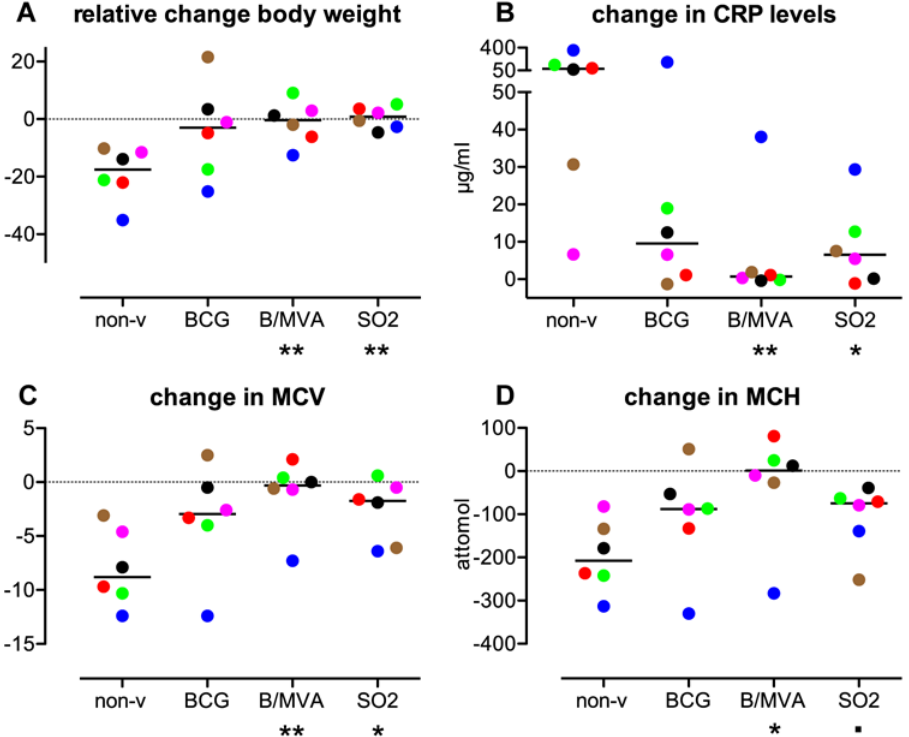
Figure 5. Evaluation of clinical measures along the infection phase. The BCG/MVA.85A regime and SO2 vaccination in comparison to non- vaccinated controls show significant protection from TB-associated wasting disease and systemic inflammation. Individual scores and group medians are plotted for relative change in body weight from start to end of the infection phase (A), change in C-reactive protein (CRP) levels (B), in mean corpuscular volume (MCV) (C), and in mean corpuscular hemoglobin (MCH) (D). For legends of colouring and symbols see legend to Figure